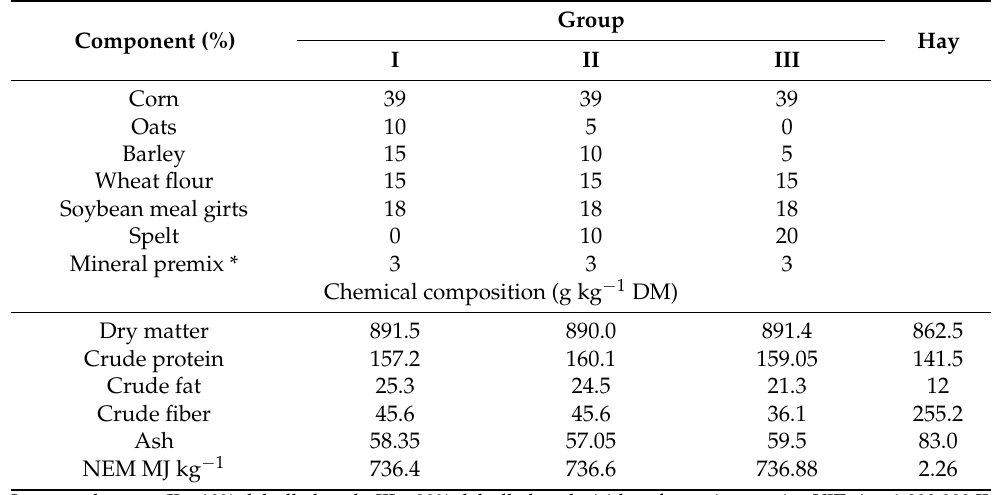
Table 1. Ingredients and proximate analysis of feed mixtures and meadow